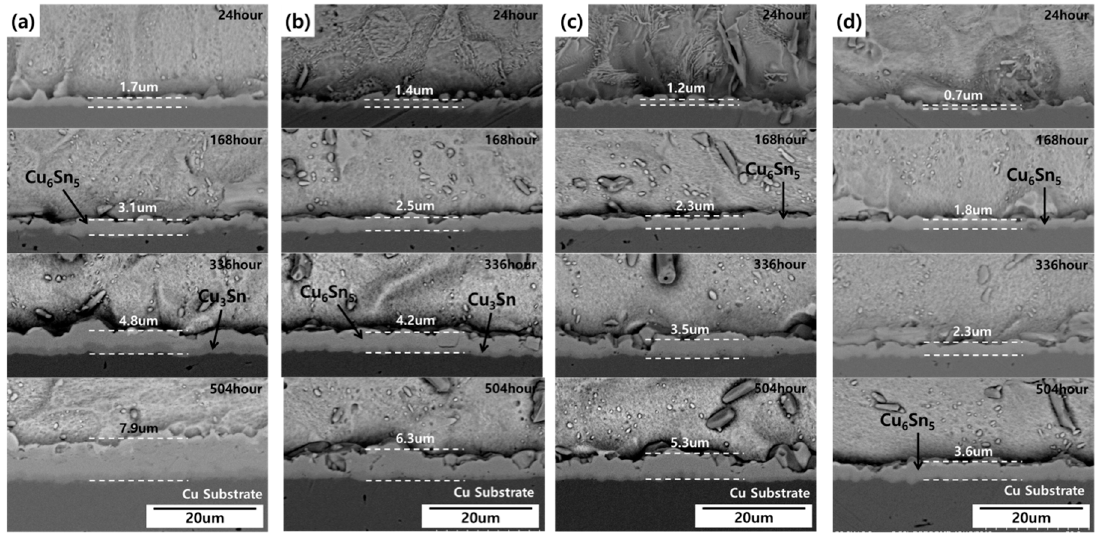
Figure 4. SEM images showing the growth of the IMC layer during the 150 ℃ aging test: ( a ) plain epoxy solder joints, ( b ) 0.01%-GNS epoxy solder joints, ( c ) 0.05%-GNS epoxy solder joints, ( d ) 0.1%-GNS epoxy solder joints.